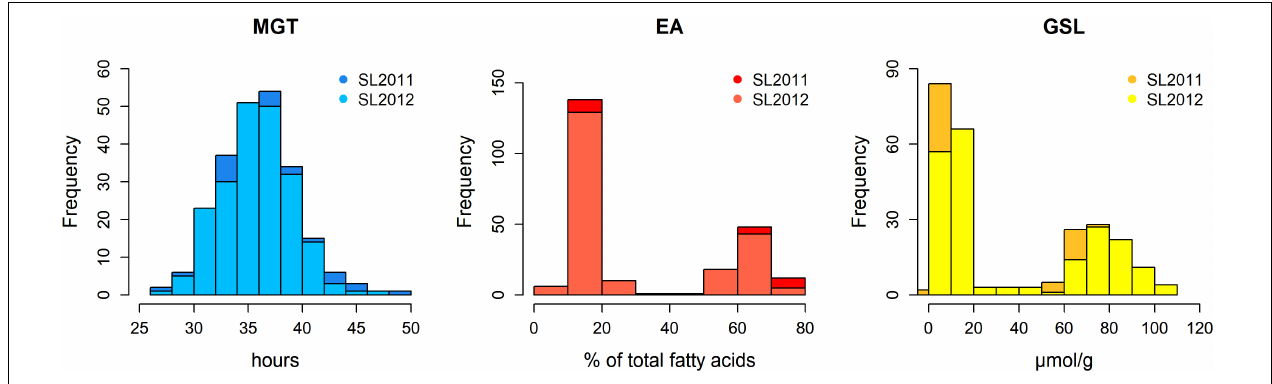
FIGURE 2 | Histograms showing the phenotypic distributions of mean germination time (MGT), seed erucic acid content (EA), and seed glucosinolate content (GSL) in a diversity panel comprising 215 winter oilseed rape genotypes produced in 2010/11 (SL2011) and 2011/12 (SL2012).